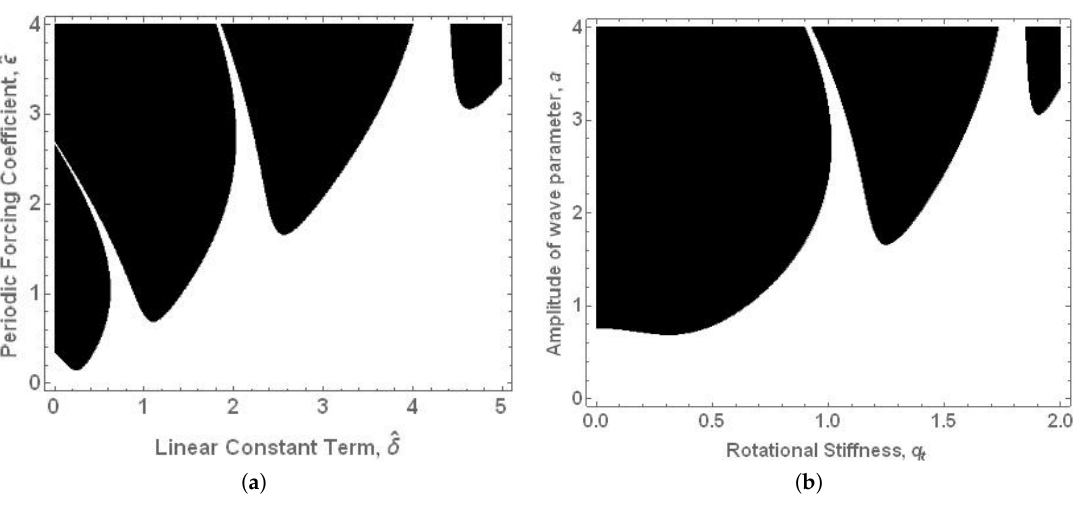
Figure 8. Stability plot for SSF with significant linear damping and with rotational damping ( a ) in ˆ δ − ˆ (cid:101) plane, ( b ) in a − q t plane.